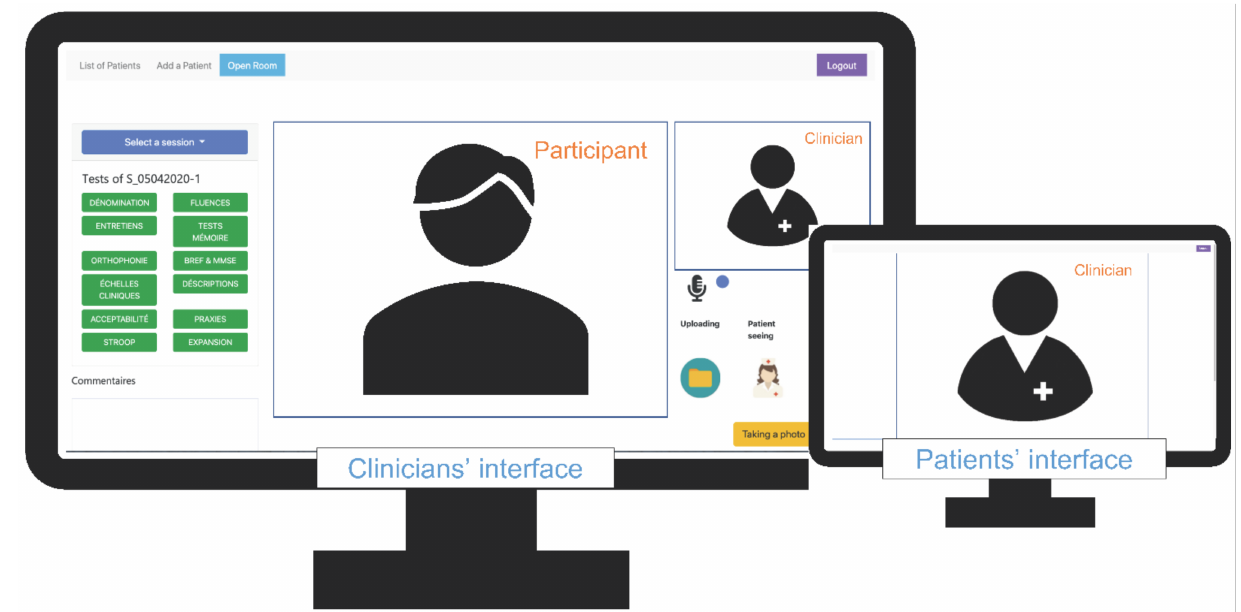
Figure 1. The teleneuropsychology platform developed for this